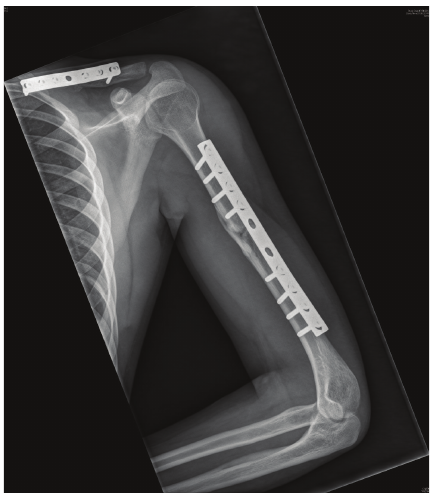
Figure 3: Follow-up radiograph showing union of the clavicle and